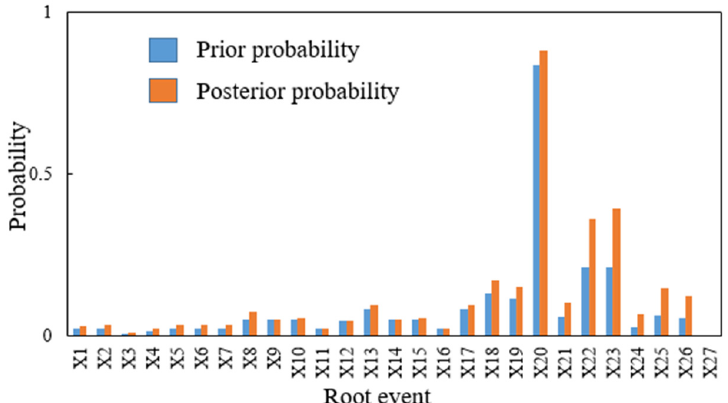
Figure 12. Prior and posterior probabilities of root nodes of the BN model.